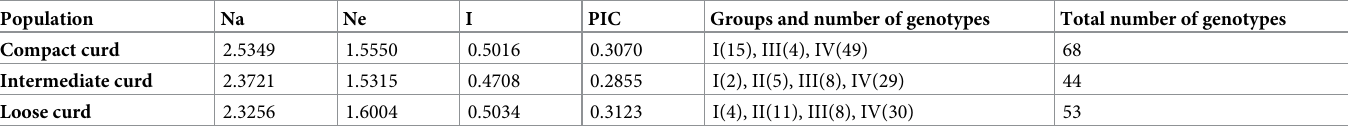
Table 3. The number of alleles (Na), effective number of alleles (Ne), Shannon’s Information index (I) and polymorphism information content (PIC) of different curd solidity populations estimated by 43 SSR markers. Population